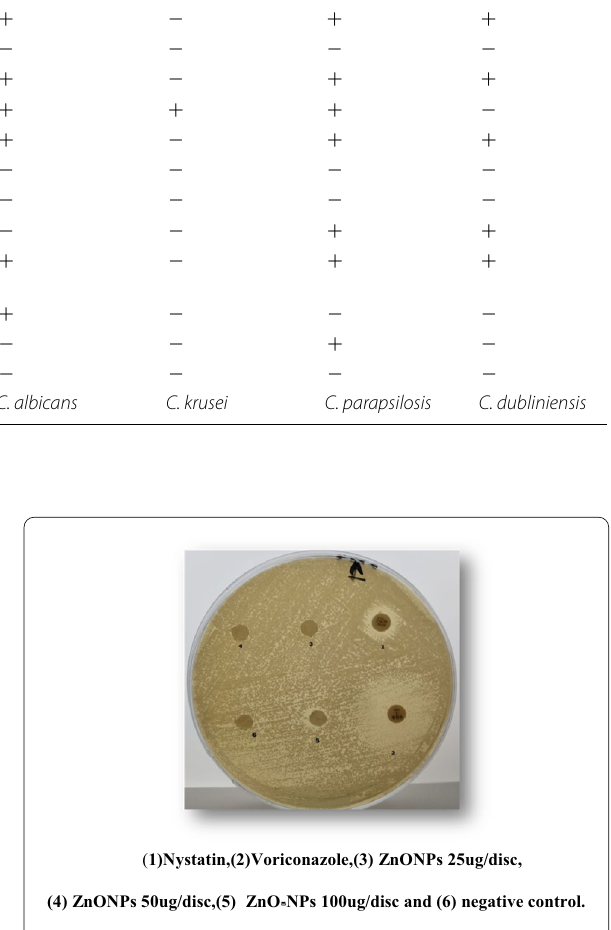
Fig. 4 Antifungal activity of zinc oxide nanoparticles along with nystatin and